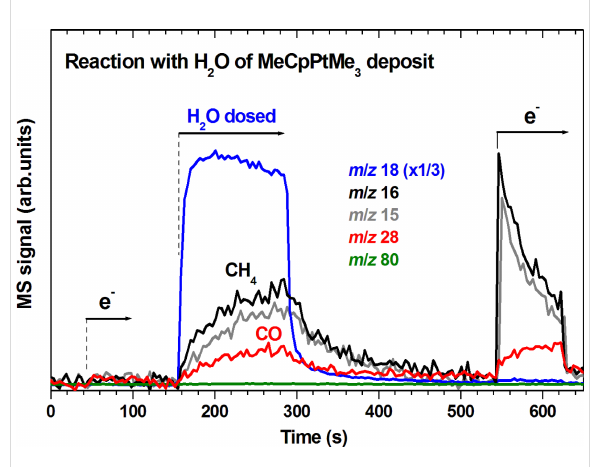
Figure 8: Desorption of CH 4 ( m / z 15 and 16) and CO ( m / z 28) from a deposit produced from more than 500 monolayers of MeCpPtMe 3 deposited successively on a Ta substrate held at 108 K and decom- posed by electron irradiation at E 0 varying between 19 eV and 31 eV followed in each deposition by annealing to 450 K to remove remaining intact precursor molecules. The m / z ratio 18 serves to monitor H 2 O leaked into the chamber or possible desorption of H 2 O from the sur- face during subsequent electron exposure. The thick deposit was held at 108 K and first exposed to electron irradiation at E 0 = 19 eV (1 mC/cm 2 ) (between 40 s and 100 s) where lack of ESD gives evi- dence of complete precursor degradation. H 2 O was then leaked into the chamber (between 155 s and 280 s) leading to surface reactions and consequent desorption of CH 4 (identified from the characteristic intensity ratio for m / z 16 and m / z 15 of 1:0.9 [10]) and CO ( m / z 28). Finally, the deposit was again irradiated at E 0 = 19 eV (1 mC/cm 2 ) be- tween 545 s and 630 s, now leading to ESD of CH 4 and CO. Included is also m / z 80 which is representative of MeCpH [32] thus ruling out any noticeable desorption of the MeCp ligand as a result of possible